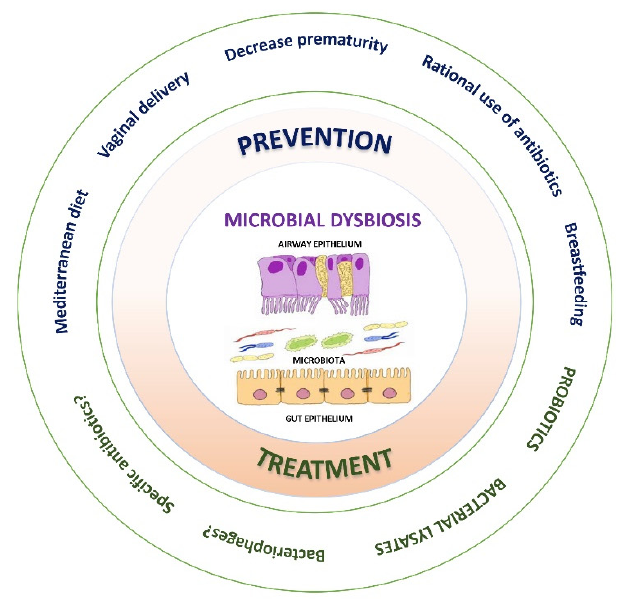
Figure 5. Strategies for prevention and/or treatment of microbial dysbiosis.